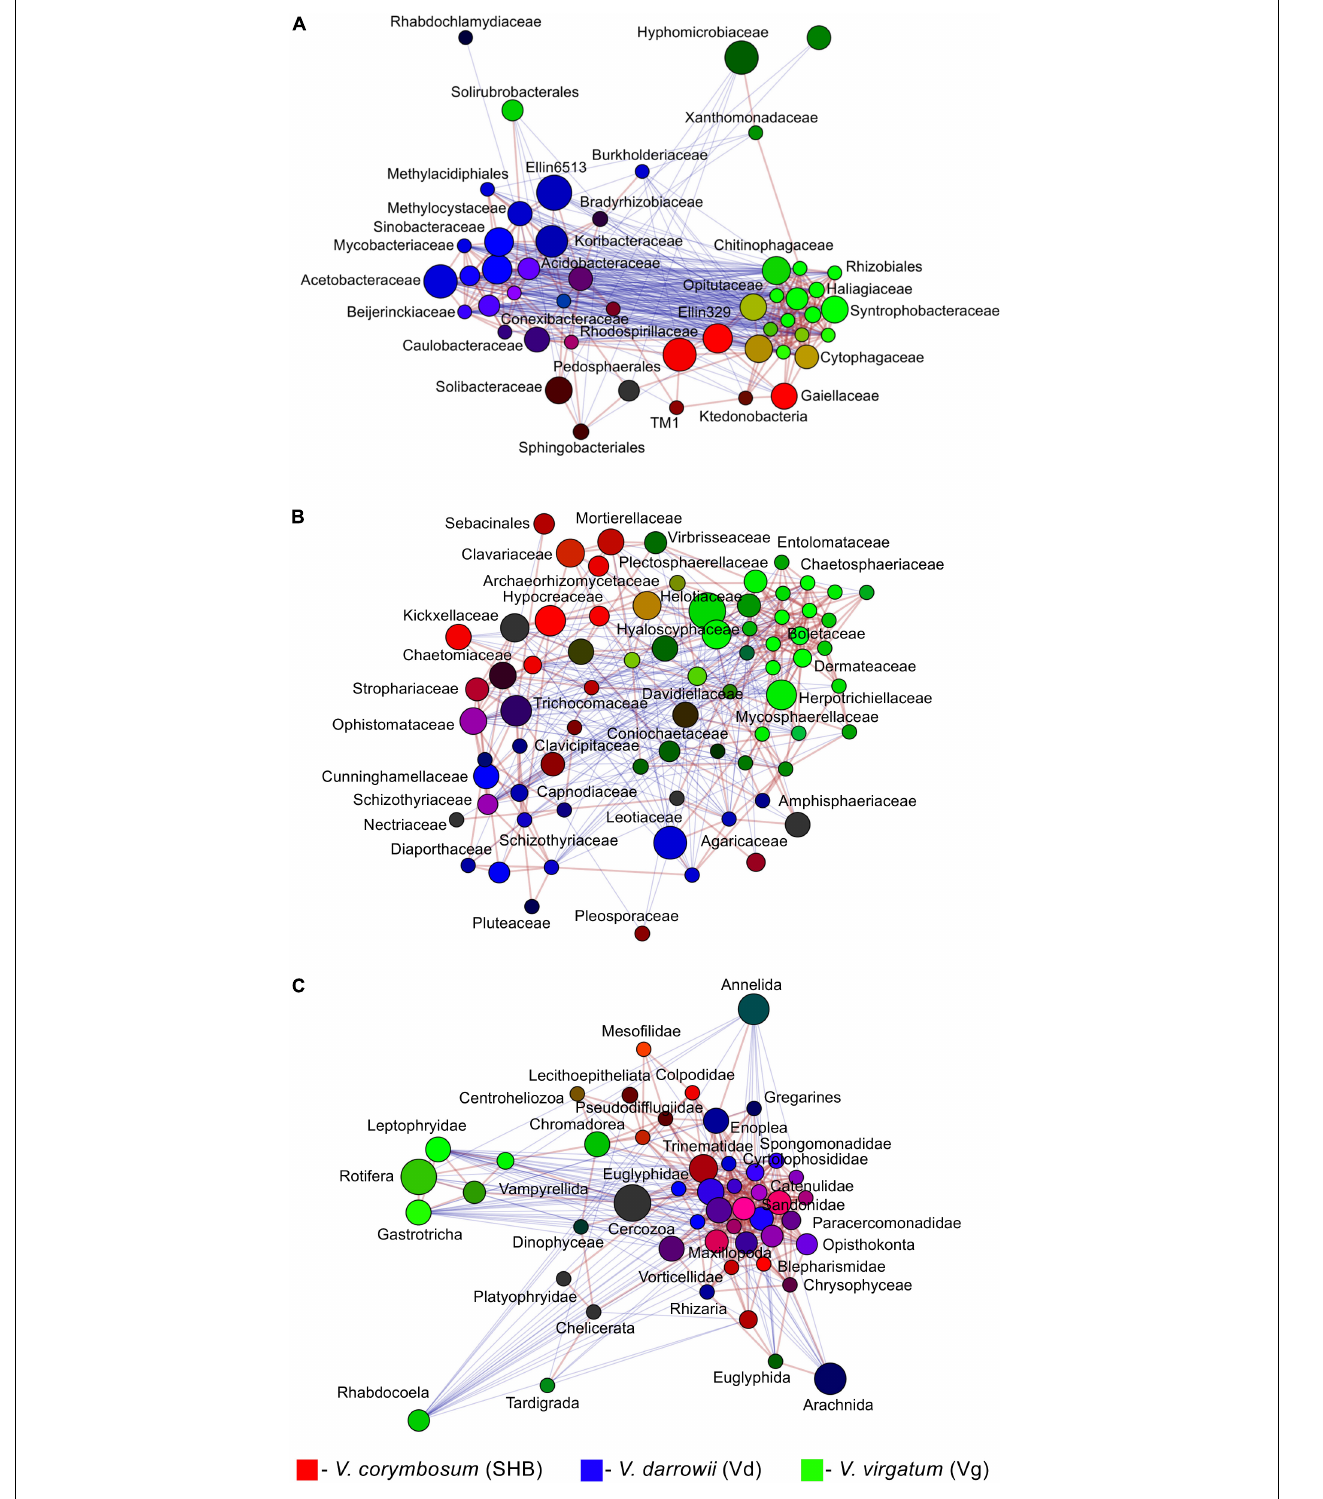
FIGURE 5 | Network analysis illustrating significant co-occurrence patterns among bacterial (A) , fungal (B) , and eukaryotic (C) taxa and Vaccinium species. The analysis was performed using Spearman correlations. Network edges represent statistically significant positive (red) and negative (blue) correlations (FDR < 0.05). Taxa are represented by nodes colored based on their association with the studied blueberry species [red, V. corymbosum (SHB), blue, V. darrowii (Vd), green, V. virgatum (Vg)]. The relative brightness (i.e., the color gradient) of each node reflects the significance level of the association.